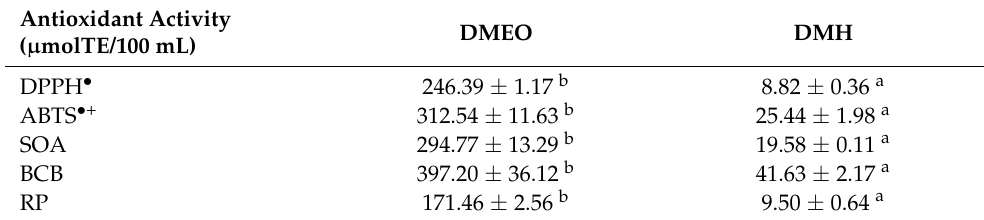
Table 2. In vitro antioxidant activity of D. moldavica essential oil (DMEO) and hydrolate (DMH). Antioxidant Activity